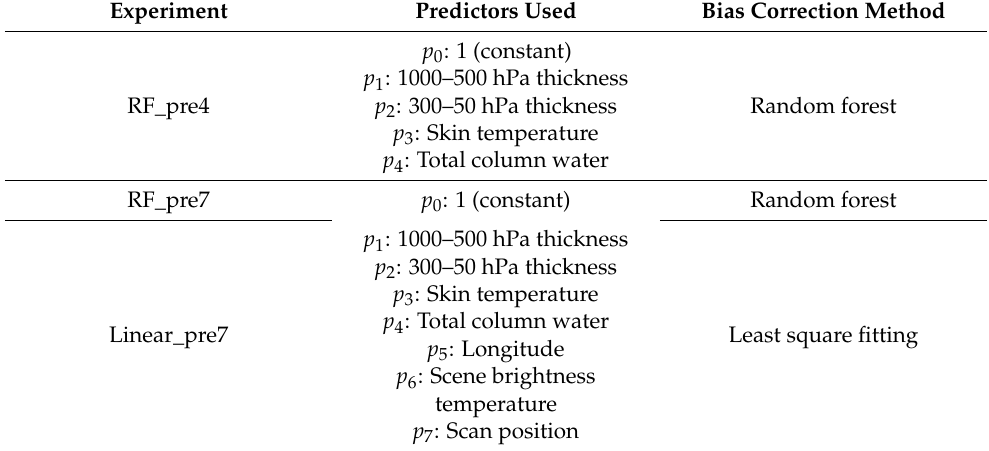
Table 1. The setting of three